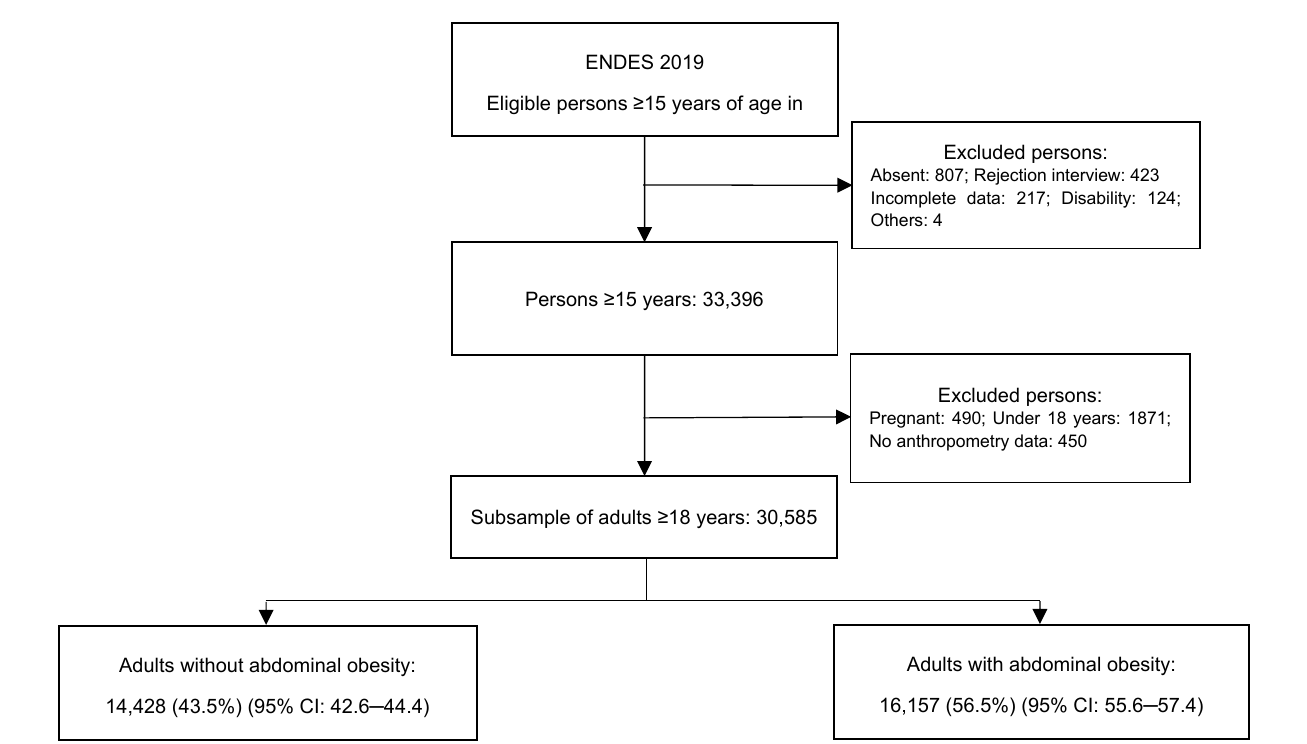
Figure 1. Flowchart of the selection of adults included in the study.